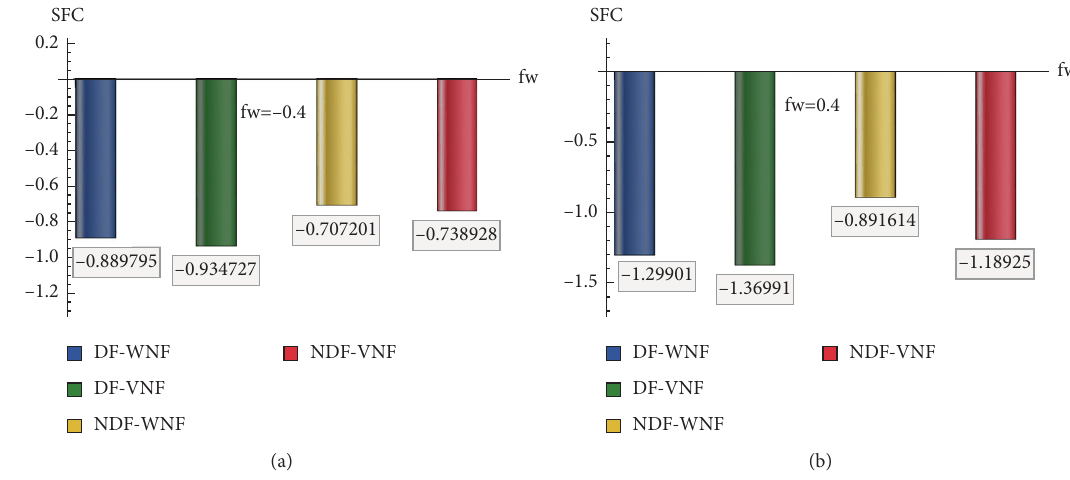
Figure 9: The skin friction coefficient on WNF and VNF on a DFPM and NDFPM with fw � − 0 . 4 (a) and fw � 0 . 4 (b). –2.0–1.5–1.0–0.5SFC